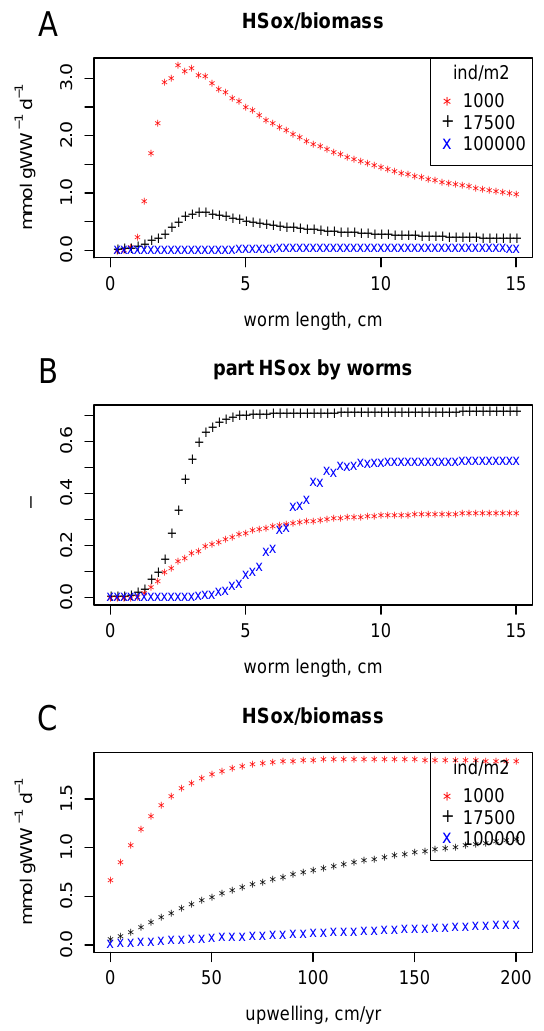
Fig. 6. (A) Biomass-specific sulfide oxidation rates, as a function of worm length for three different worm densities (1000, 17500, 100000indm − 2 ) and for an upwelling rate=20cmyr − 1 . (B) Part of sulfide oxidation performed by the Siboglinid as a function of worm length. (C) Biomass-specific sulfide oxidation rates as a func- tion of upwelling rate, for a worm of 11cm